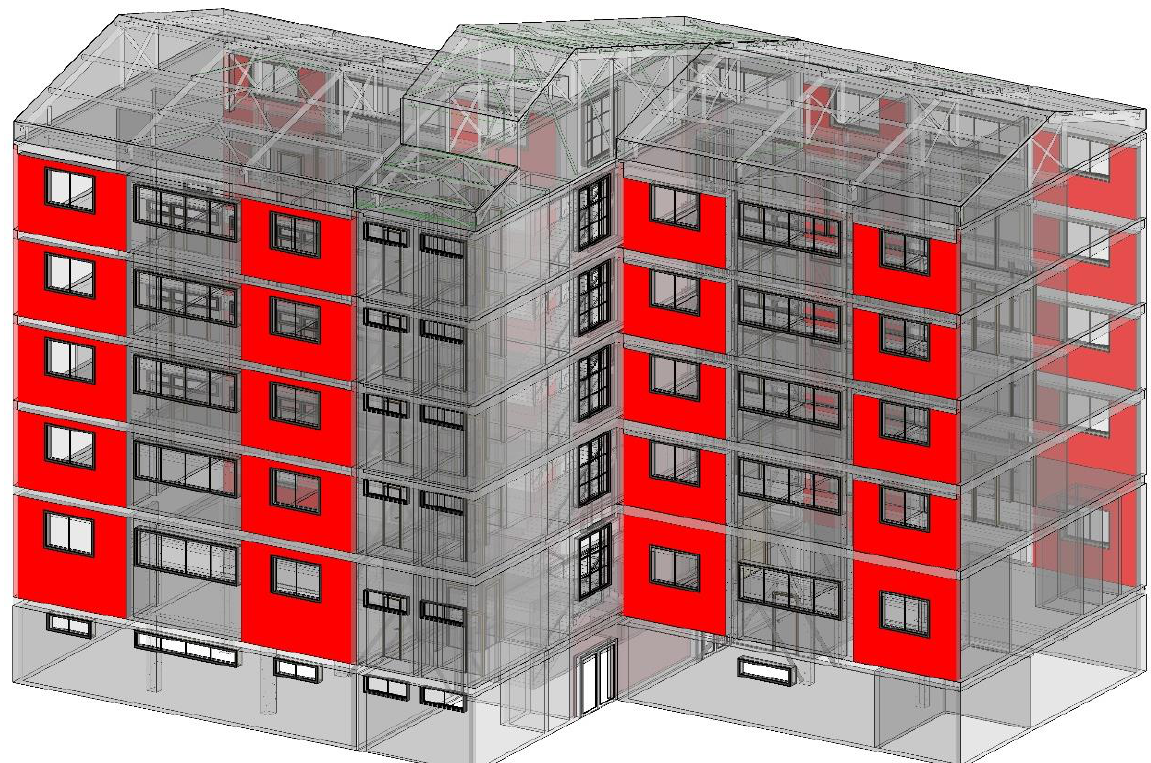
Figure 22. Additional RC perimeter